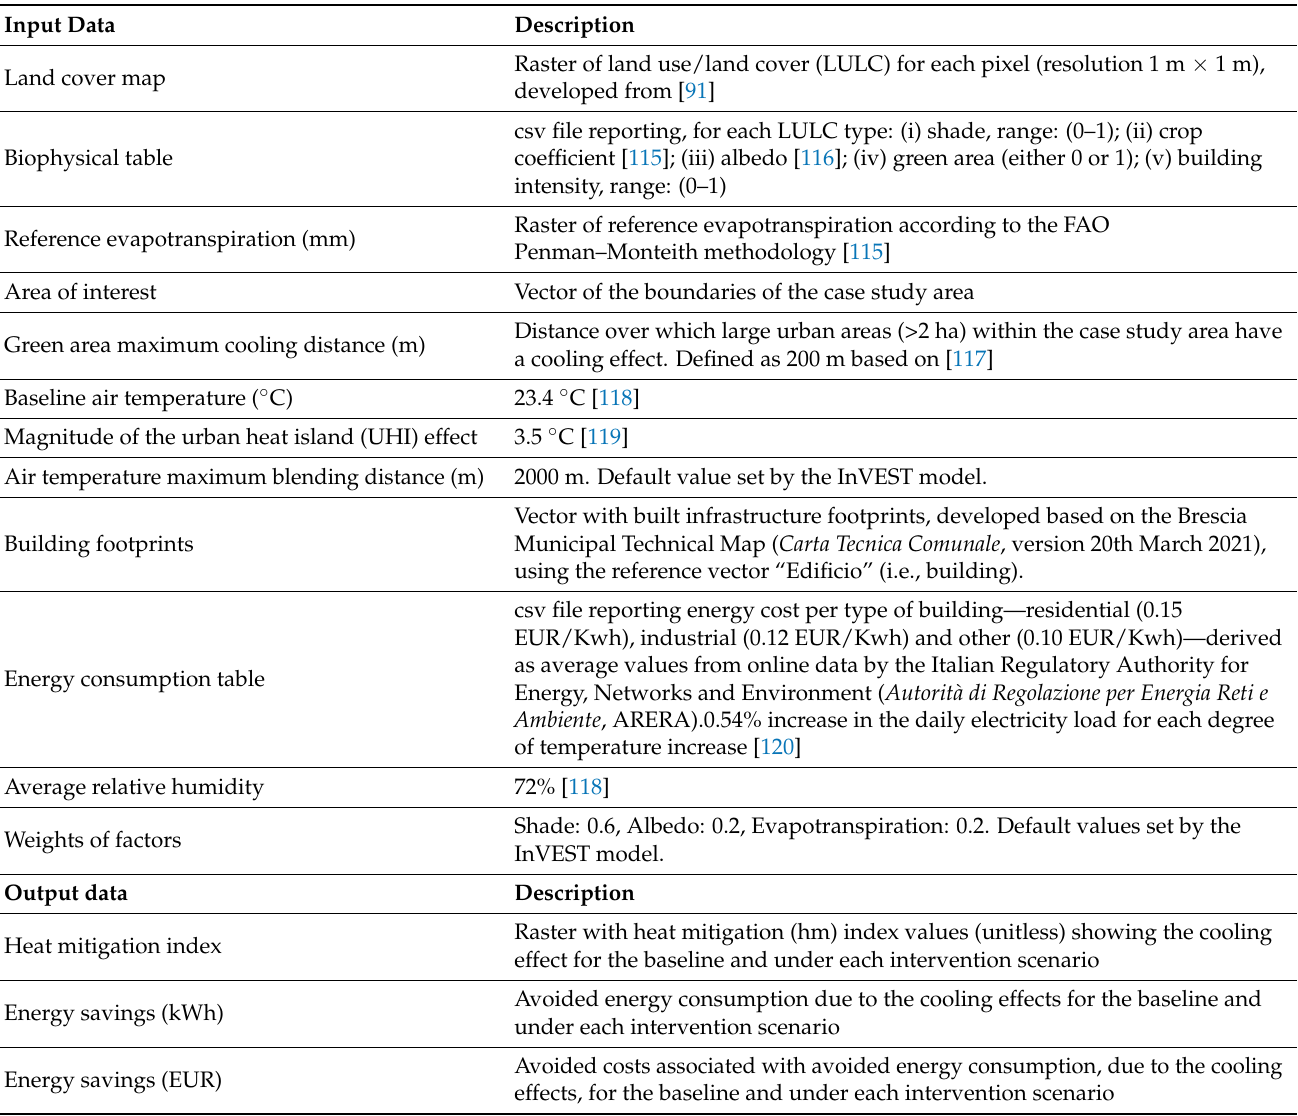
Table 10. Input and output data for the assessment of temperature regulation and urban